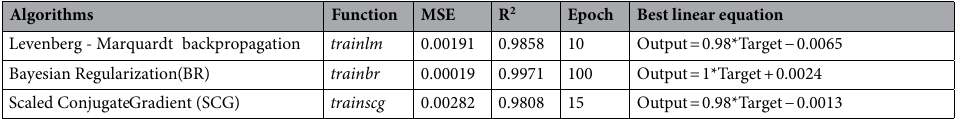
Table 6. MLP training algorithms for the absorption